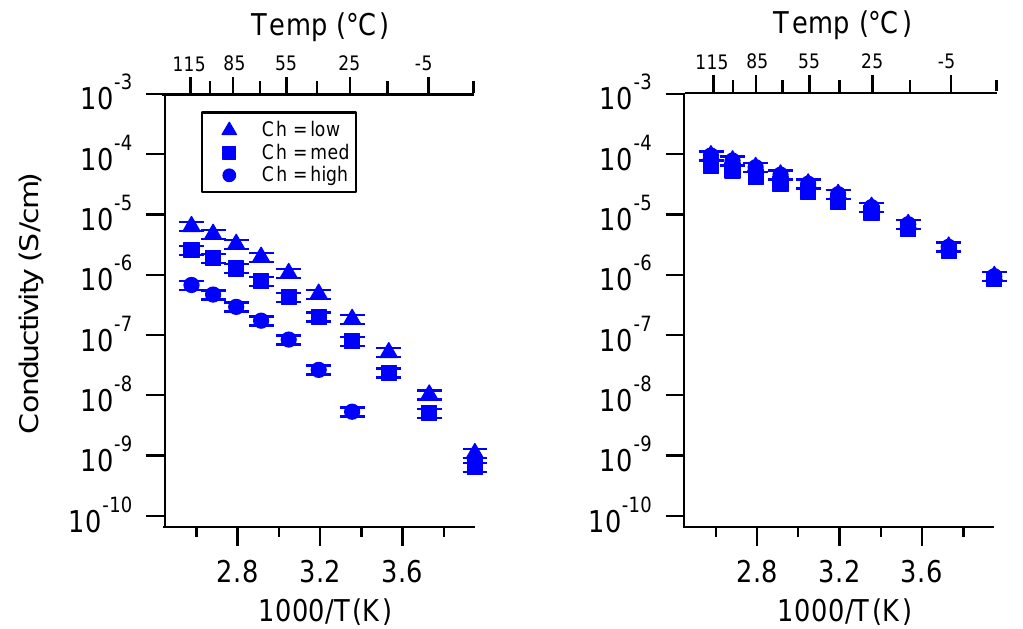
Figure A16. Conductivity as a function of charge density for PEGDMA1000_SSNa (left) and PTHFDA1000_STFSINa (right) SIPEs swelled with TEG. Temperatures ranged from − 20 °C to 115 °C.